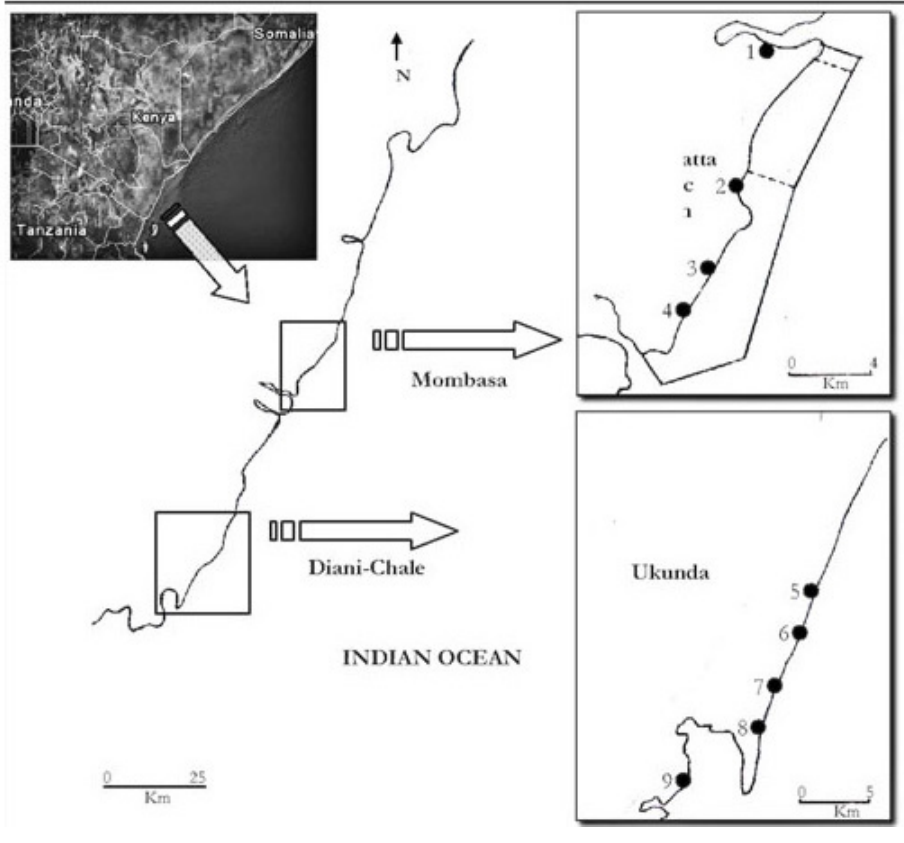
Fig. 1. Mombasa Marine Park is 10 km² (represented by the dotted line) and the Reserve is 200 km² (represented by the solid